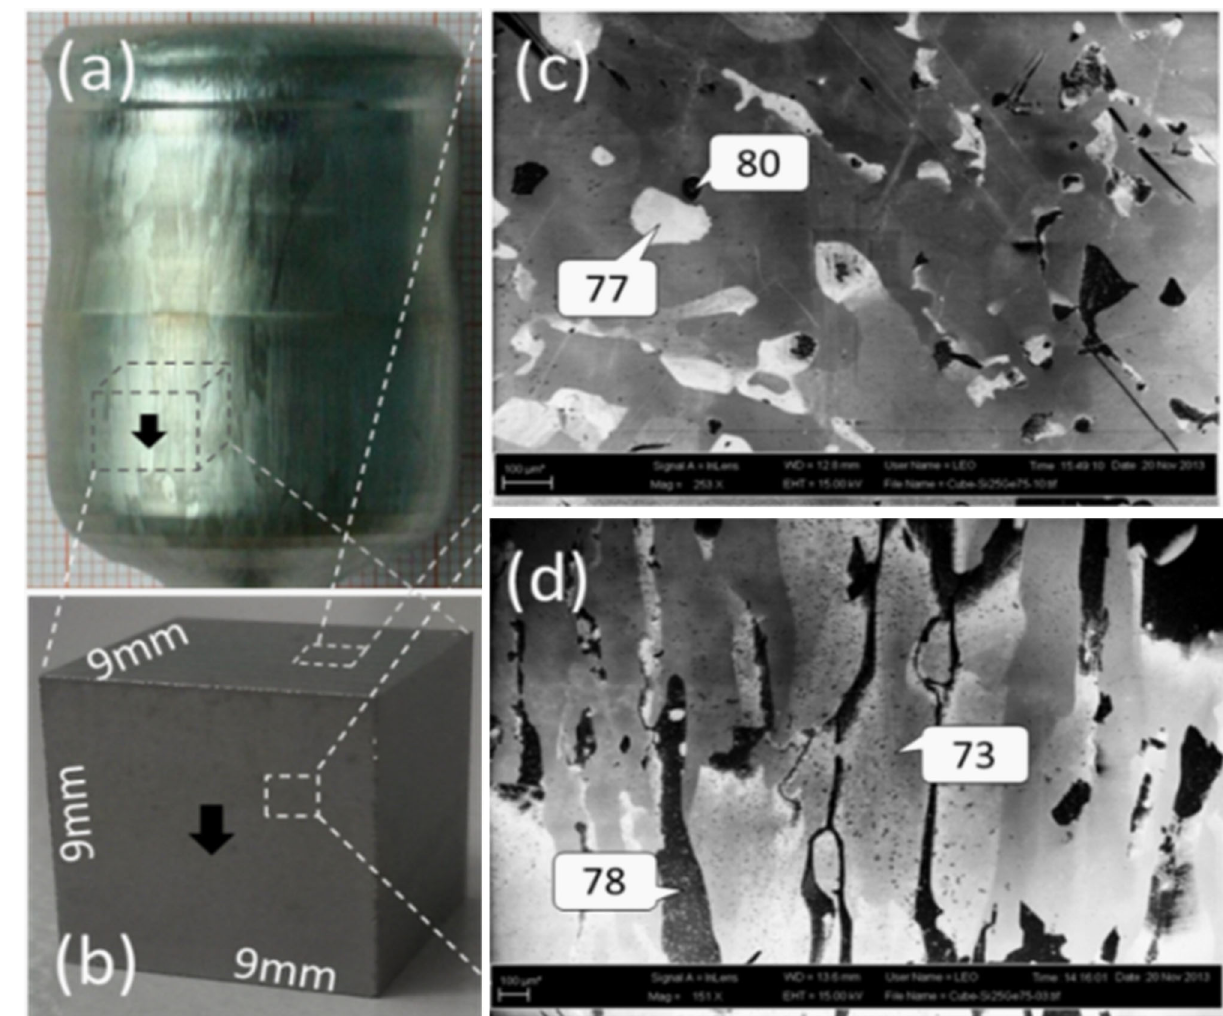
Fig. 9 a Cylindrical crystal (35 mm in diameter) of a SiGe alloy prepared by Czochralski process, the arrow indicates the pulling direction. b A cube (9 × 9 × 9 mm³) cut from the cylinder. c and d SEM images from the cube top and side , respectively, including EDX data in at.%. The surface of the cube was etched in 30% H 2 O 2